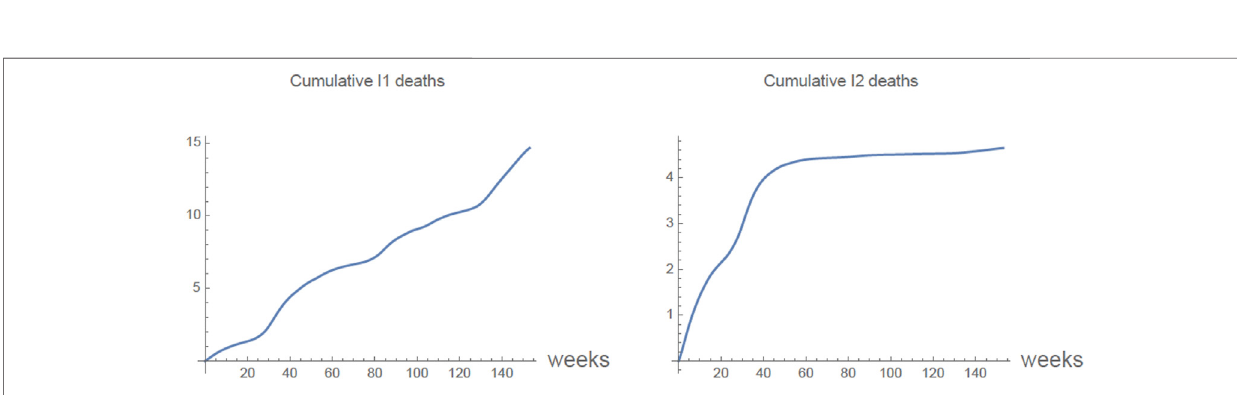
FIGURE 9 | Only previously infected of the 875,000 9 years olds are vaccinated. The cumulative number of deaths each week of primarily infected I 1 ( t ) and secondary infected I 2 ( t